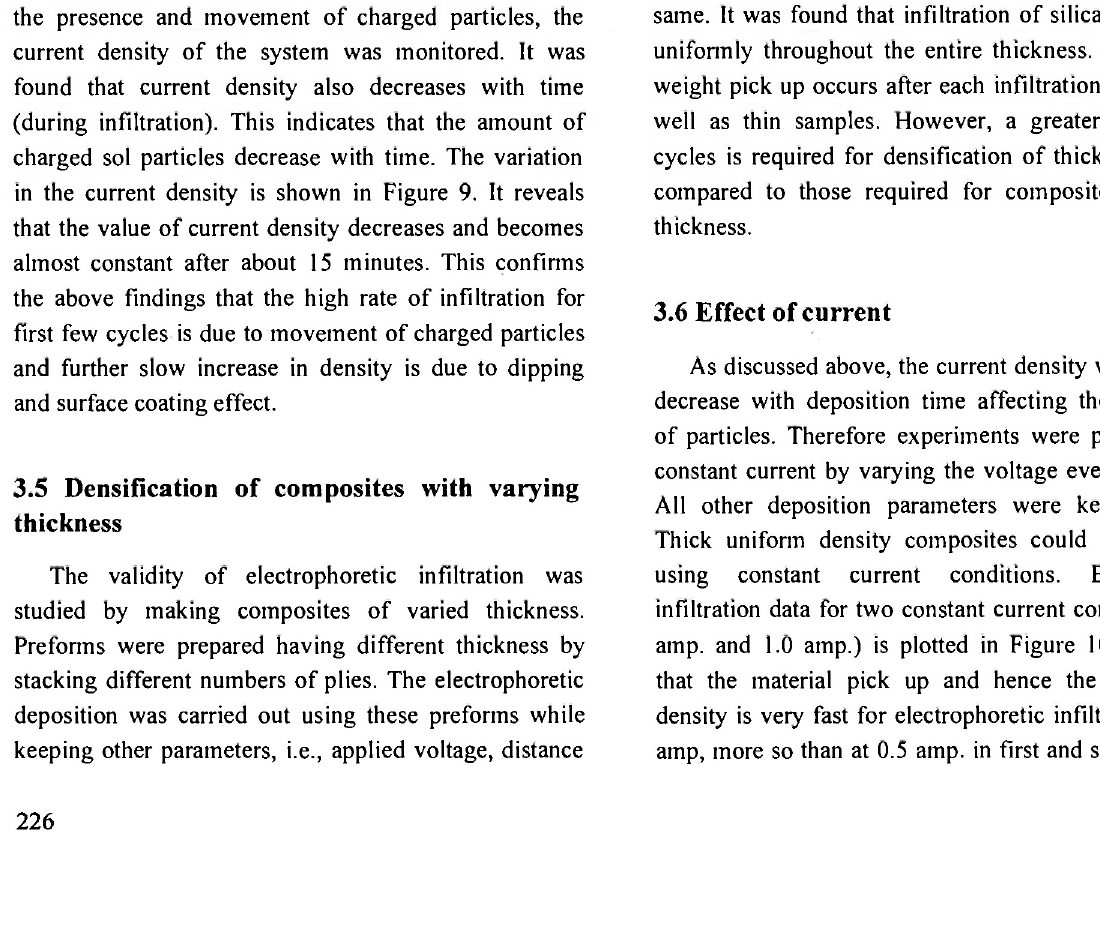
Fig. 8: Effect of infiltration time on densification with number of infiltrations (colloidal silica sol)